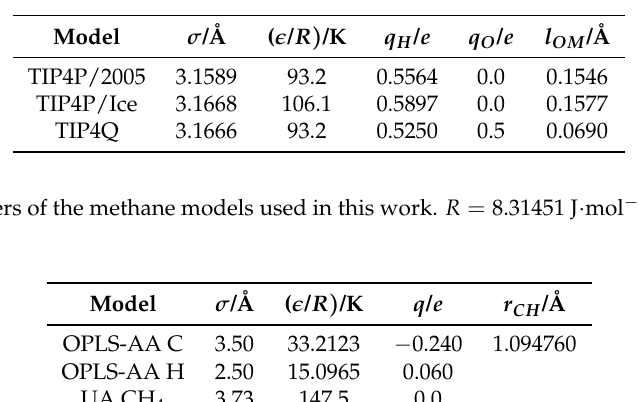
Table 4. Parameters of the water models used in this work. R = 8.31451 J · mol − 1 · K − 1 is the molar gas constant.